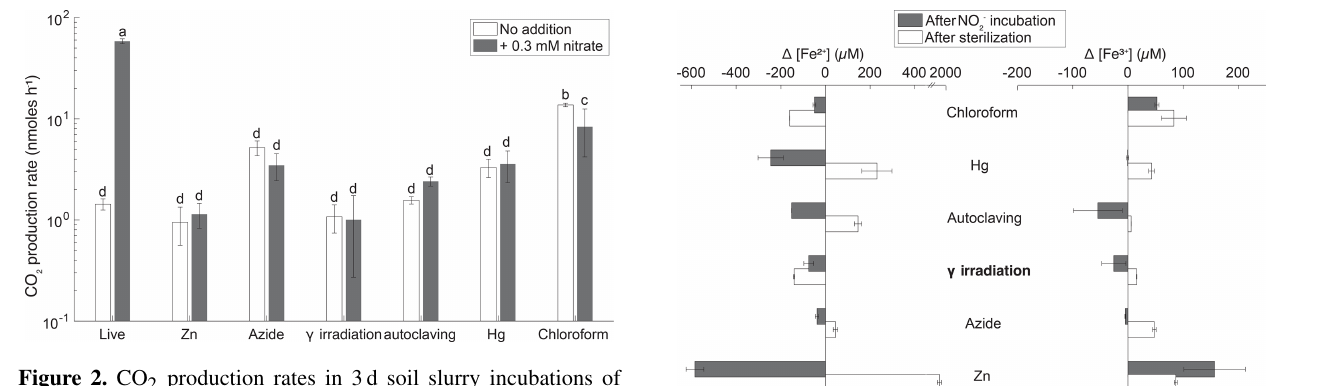
. Er- 3 centration in Quistococha peat soil incubations after sterilization (difference between sterilization baseline and live baseline value) and after NO − amendment and incubation (difference between 2 NO − and control incubations). Note the difference in scales. Val- 2 ues represent the extractable fraction of both species. Error bars are 1 SD ( n = 2). The y axis represents treatments, as in the legend of Fig.